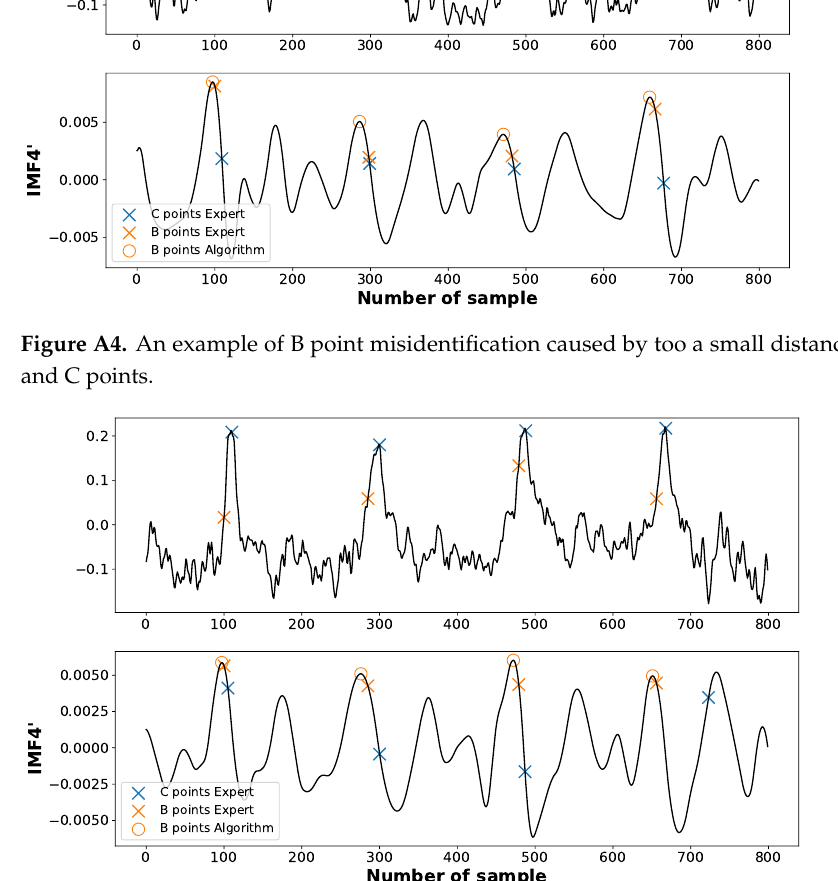
Figure A5. An example of the discrepancy between the indication of an expert and the algorithm due to an inaccurate expert assessment of the moment of a gradient change in the ICG